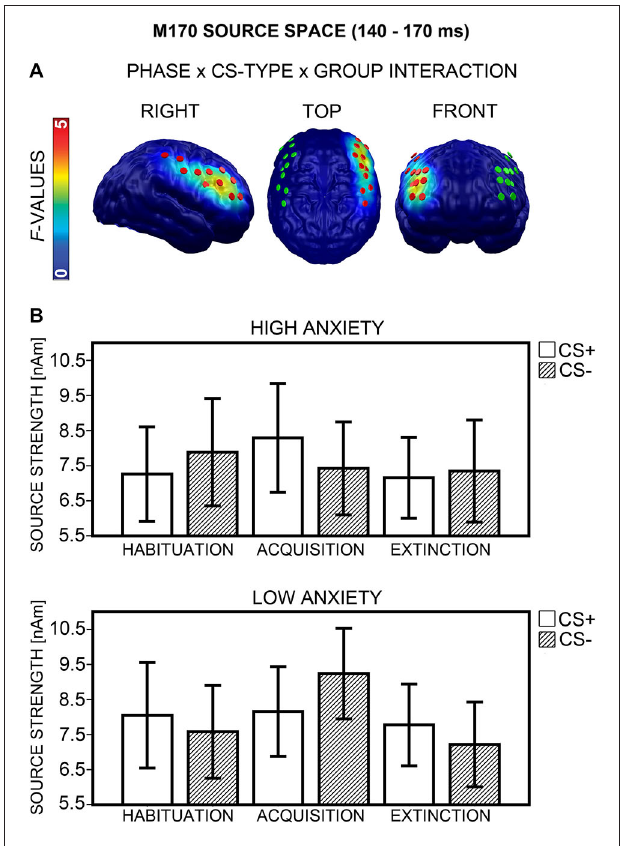
FIGURE 10 | Visualization of the M170 source space effect (140–170 ms) . (A) F -values for the Phase × CS-Type × Group interaction calculated for the M170 time-interval are projected onto standard brains, displayed from right, top, and frontal view. Red disks visualize the dipole locations used for post hoc statistical analyses, while green disks visualize the dipole locations of the mirror-symmetric left-hemispheric cluster. (B) Mean source strengths (95% confidence intervals) are shown for paired (CS+; white bars) and unpaired (CS − ; striped bars) stimuli for the high and low anxiety groups and the three conditioning